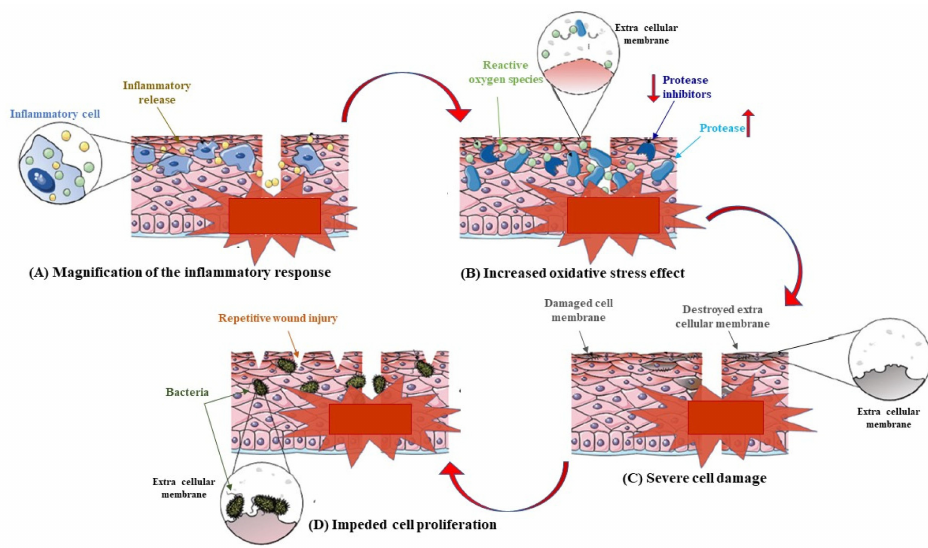
Figure 1. The harmful inflammatory cycle of chronic wounds. During chronic wounds, the anomalous accumulation of inflammatory cells in the wound produces an amplification of the inflammatory response. leading to the destruction of the extra-cellular membrane and the degradation of growth factors and their receptors. The ROS production is then intensified, disrupting the redox balance of cells and enhancing the degradation of the extra-cellular membrane. A delay in the wound healing increases the risk of wound infection